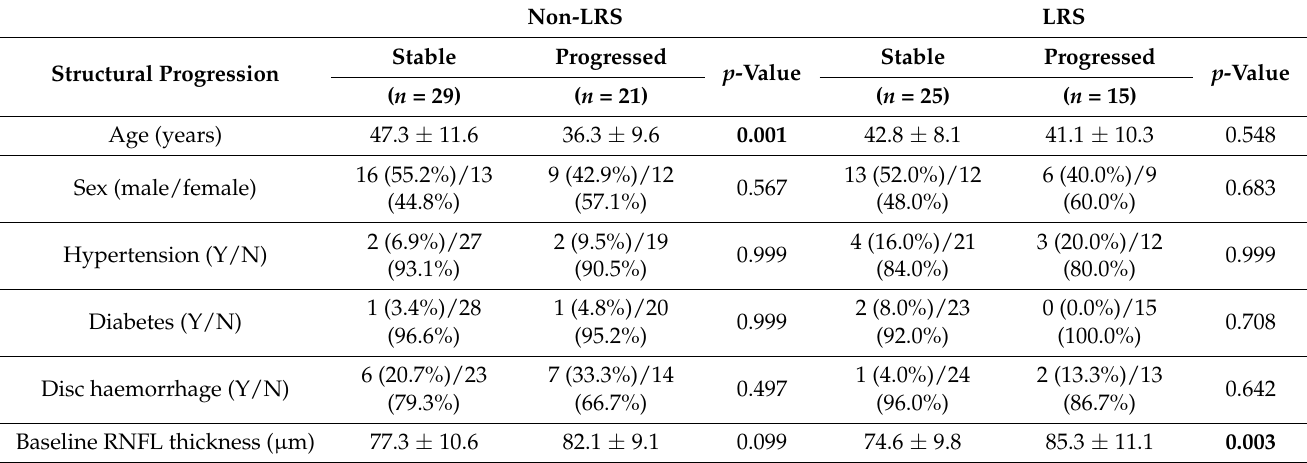
Table 2. Comparison of variables between stable eyes and eyes with structural progression in the non-LRS and LRS